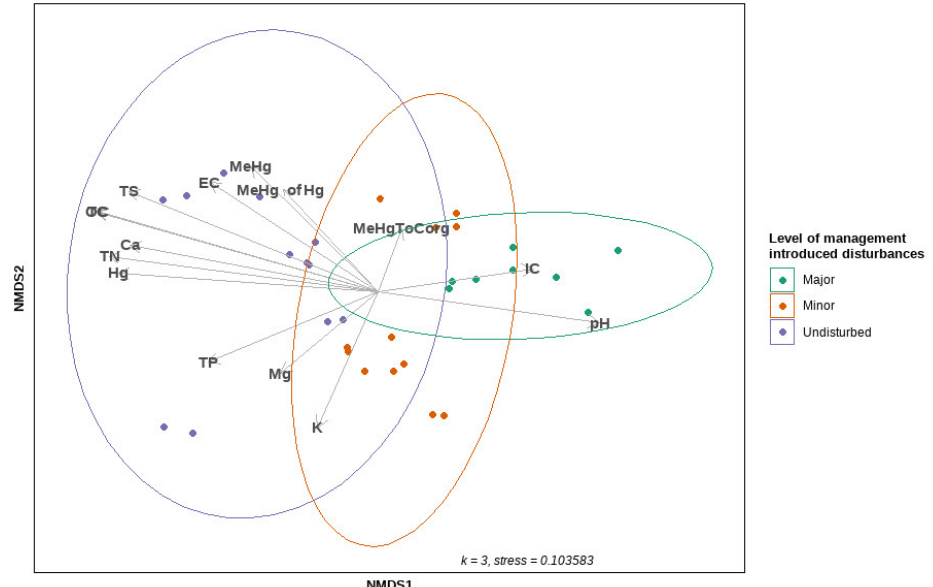
Figure 6. The ordination plot of non-metric MDS, using Bray–Curtis dissimilarity distances on the square root-transformed community data (abundance matrix); 95% confidence ellipses are fitted around centroids that represent the levels of management-induced disturbances, along with the environmental variables fitted on the ordination plot using the “envfit” function (vegan